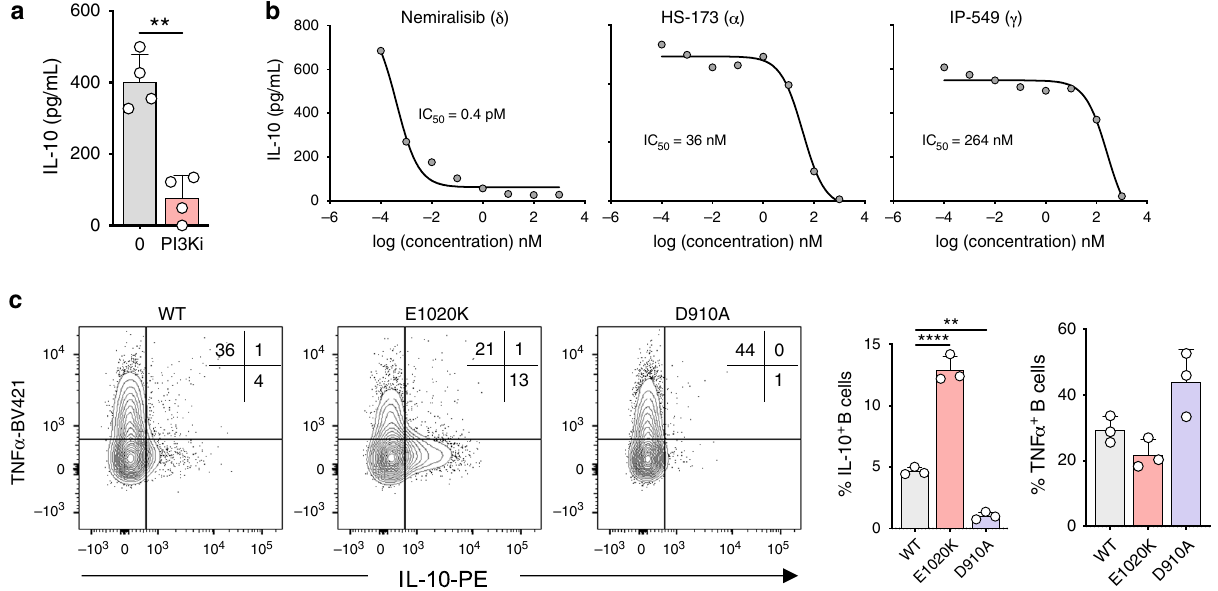
Fig. 4 PI3K δ regulates IL-10 expression in human and mouse B cells. a IL-10 expression in human B cells stimulated through TLR9± pan inhibition of PI3K (PI3Ki, ZSTK474) ( n = 4, pval = 0.008). b IL-10 expression in human B cells stimulated through TLR9± inhibitors for speci fi c family members of PI3K: these being δ (Nemiralisib), γ (IP-549), or α (HS-173), over a range of concentrations ( n = 4). c IL-10 and TNF expression in mouse B cells after stimulation through TLR9. Mice used were wild type (WT), hyperactive PI3K δ (E1020K), or catalytically inactive PI3K δ (D910A) ( n = 3, pval = 0.002 and <0.0001). Each data point represents individual donors or mice. Data presented are mean ± SD. Statistical testing in fi gures in a was done by a paired t test, or in c by a one-way ANOVA with Dunnet ’ s multiple comparisons test. ** P < 0.01, **** P < 0.0001 and all signi fi cant values are